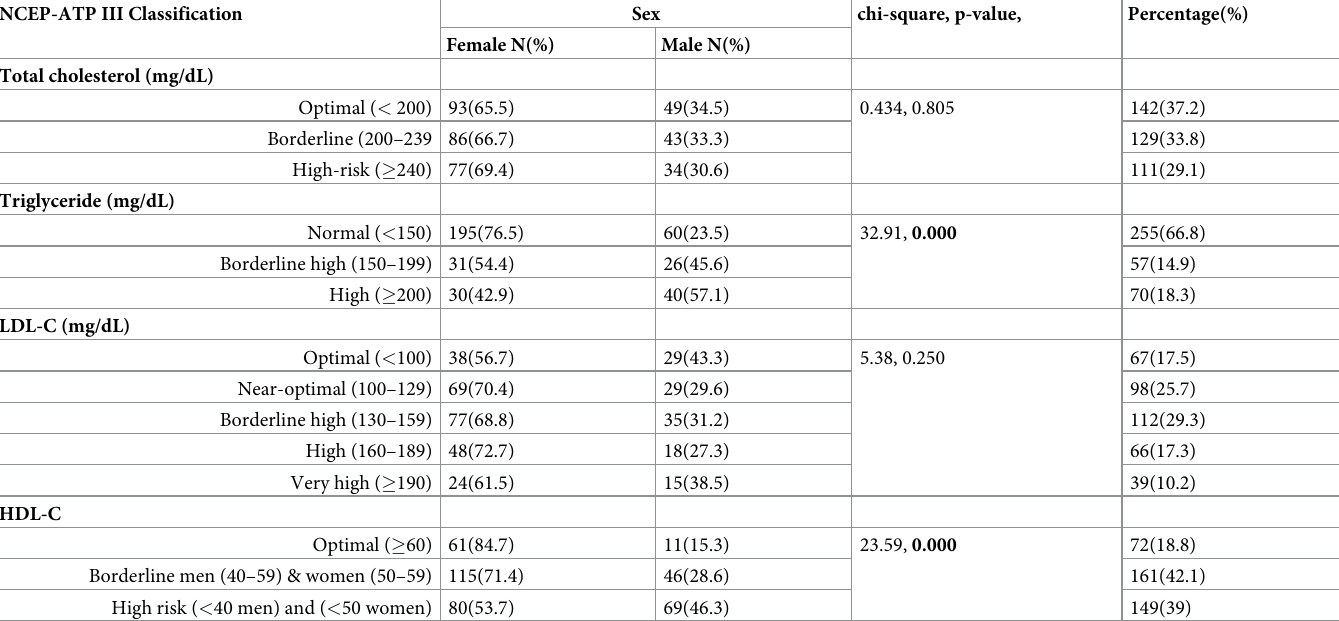
Table 3. NCEP-ATP III based characterization of lipid disorders in HIV infected patients in Asmara, Eritrea. NCEP-ATP III